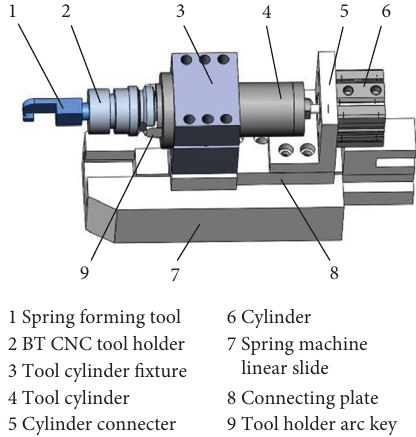
Figure 2: Schematic diagram of the automatic loose-clamp device.